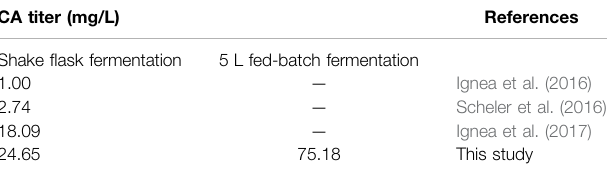
TABLE 1 | Carnosic acid titers in S. cerevisiae reported to date. CA titer